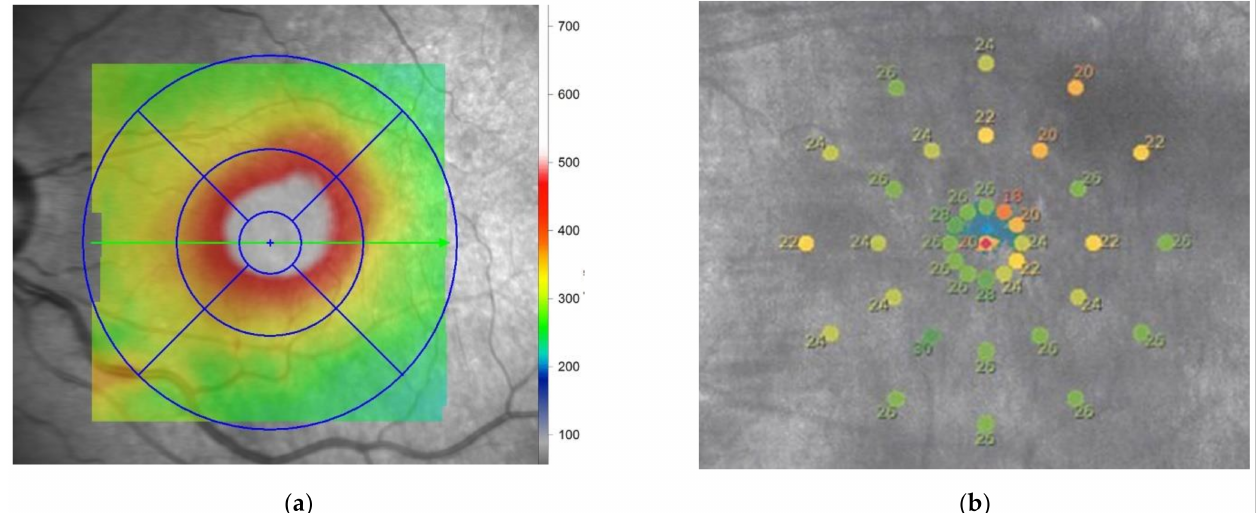
Figure 2. Retinal sensitivity in an eye with diabetic macular edema. ( a ) Retinal thickness map measured by optical coherence tomography. The thickness is increased at the superior temporal area to the central macula; ( b ) Mixed values of retinal sensitivity are presented in the macular area by maia. The average retinal sensitivity is 24.3 dB. Note that the low retinal sensitivity corresponds to the thick retina, suggesting retinal edema. The best-corrected visual acuity in the eye was